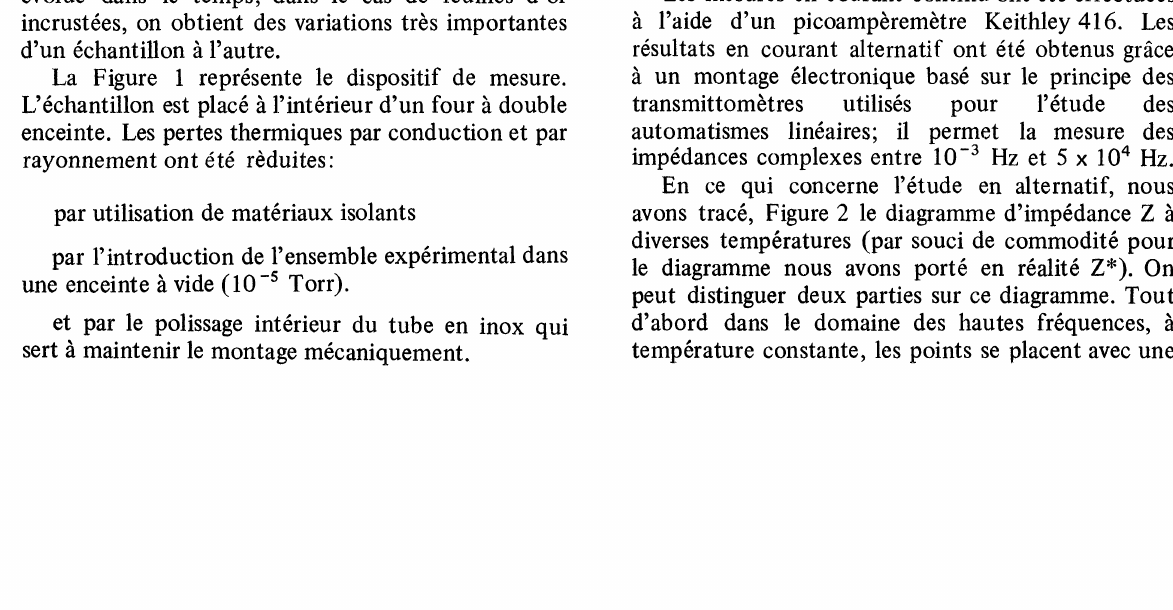
kube inox poll in4 rieur